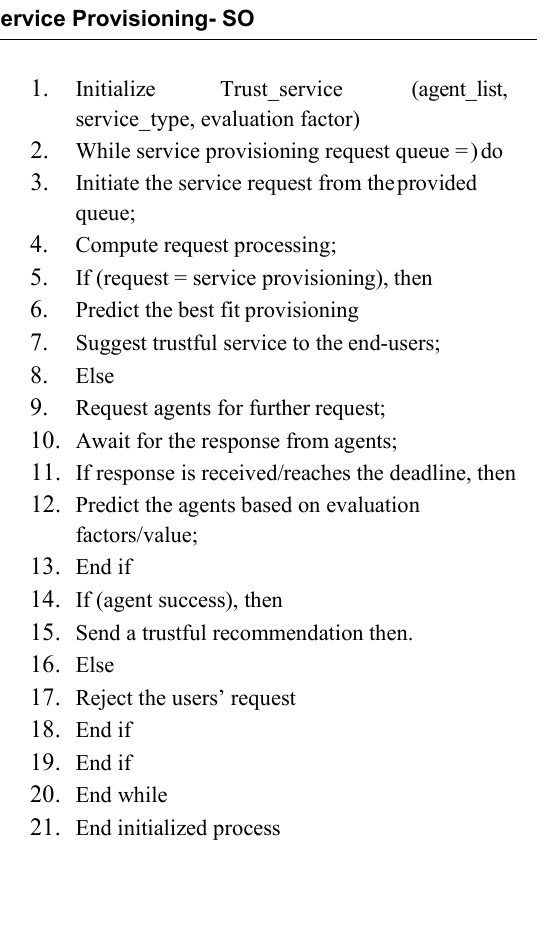
Algorithm 1: Trustful Lightweight